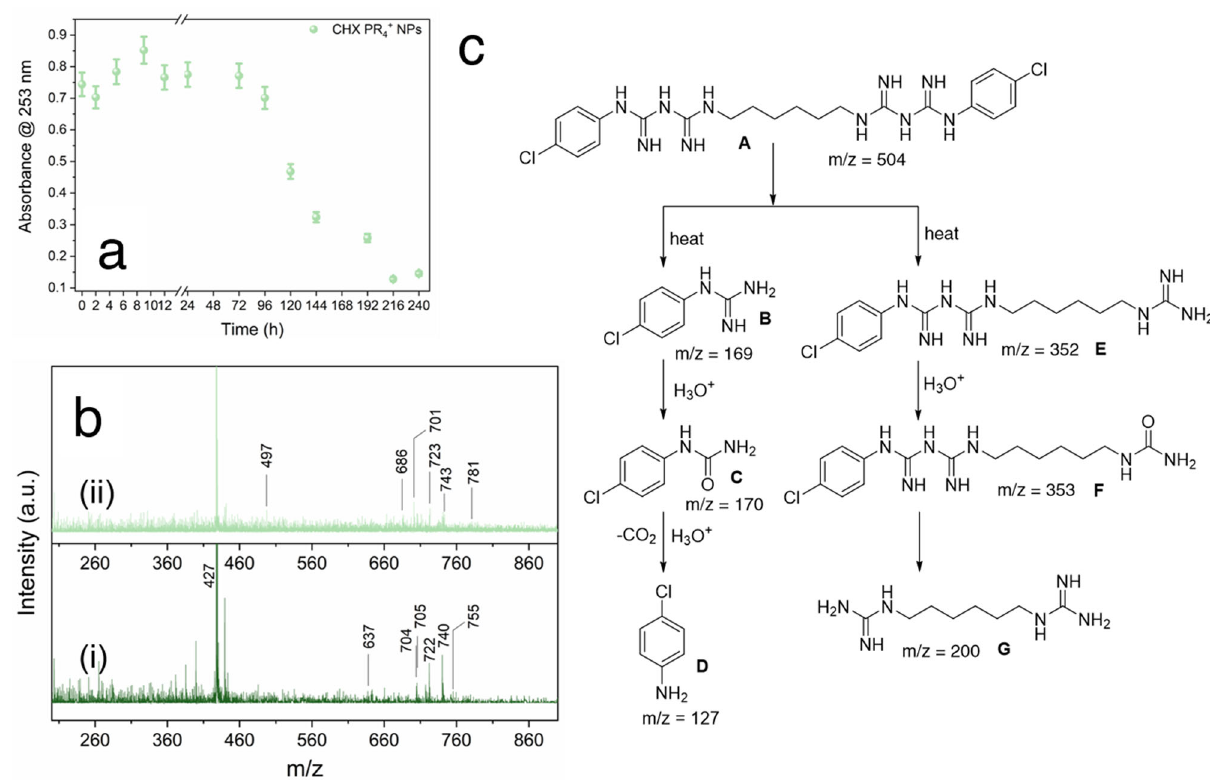
Fig. 6 Biodegradation of CHX PR 4 + NPs in arti fi cial saliva tracked for consecutive 10 days. a The measured absorbance of CHX PR 4 + NPs at 253 nm; b mass spectra of (i) CHX PR 4 + NPs in saliva and (ii) degraded CHX PR 4 + NPs; c the proposed scheme for the degradation pathway concluded from the mass spectrometry